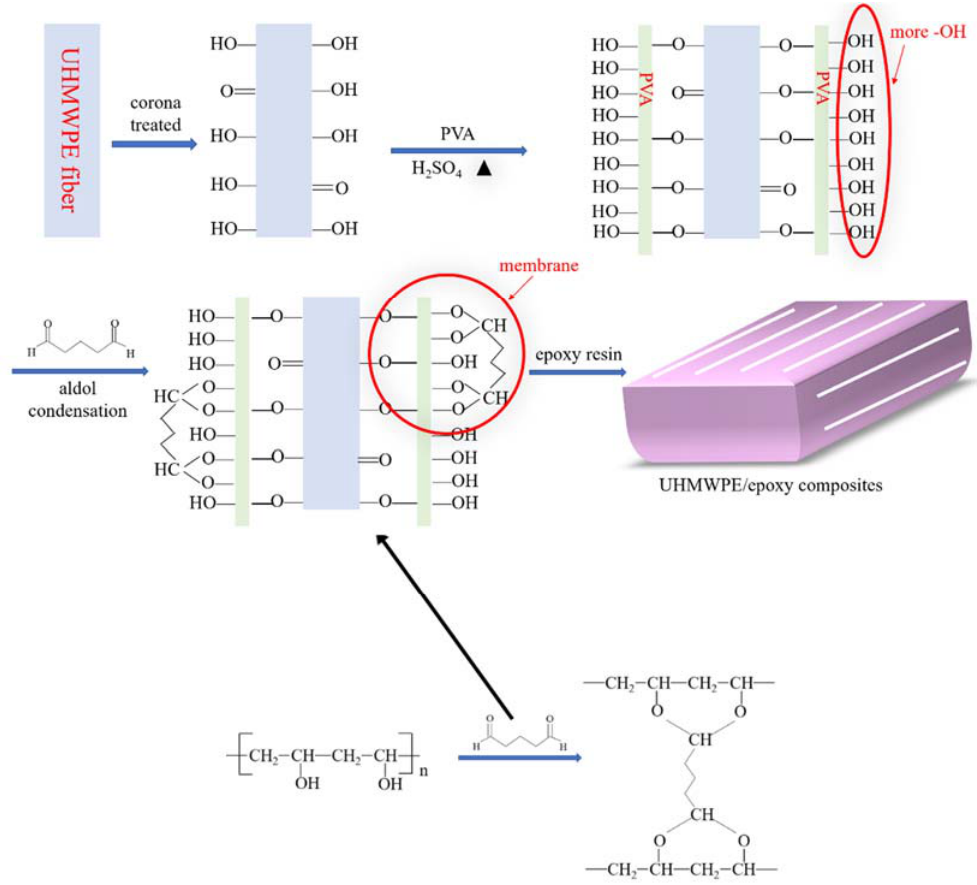
Figure 3. Mechanism of the UHMWPE fiber treated by Corona ‐ PG ‐ 2S. Table 3. Mass fraction of epoxy, curing agent, the fiber in UHMWPE/epoxy composite.